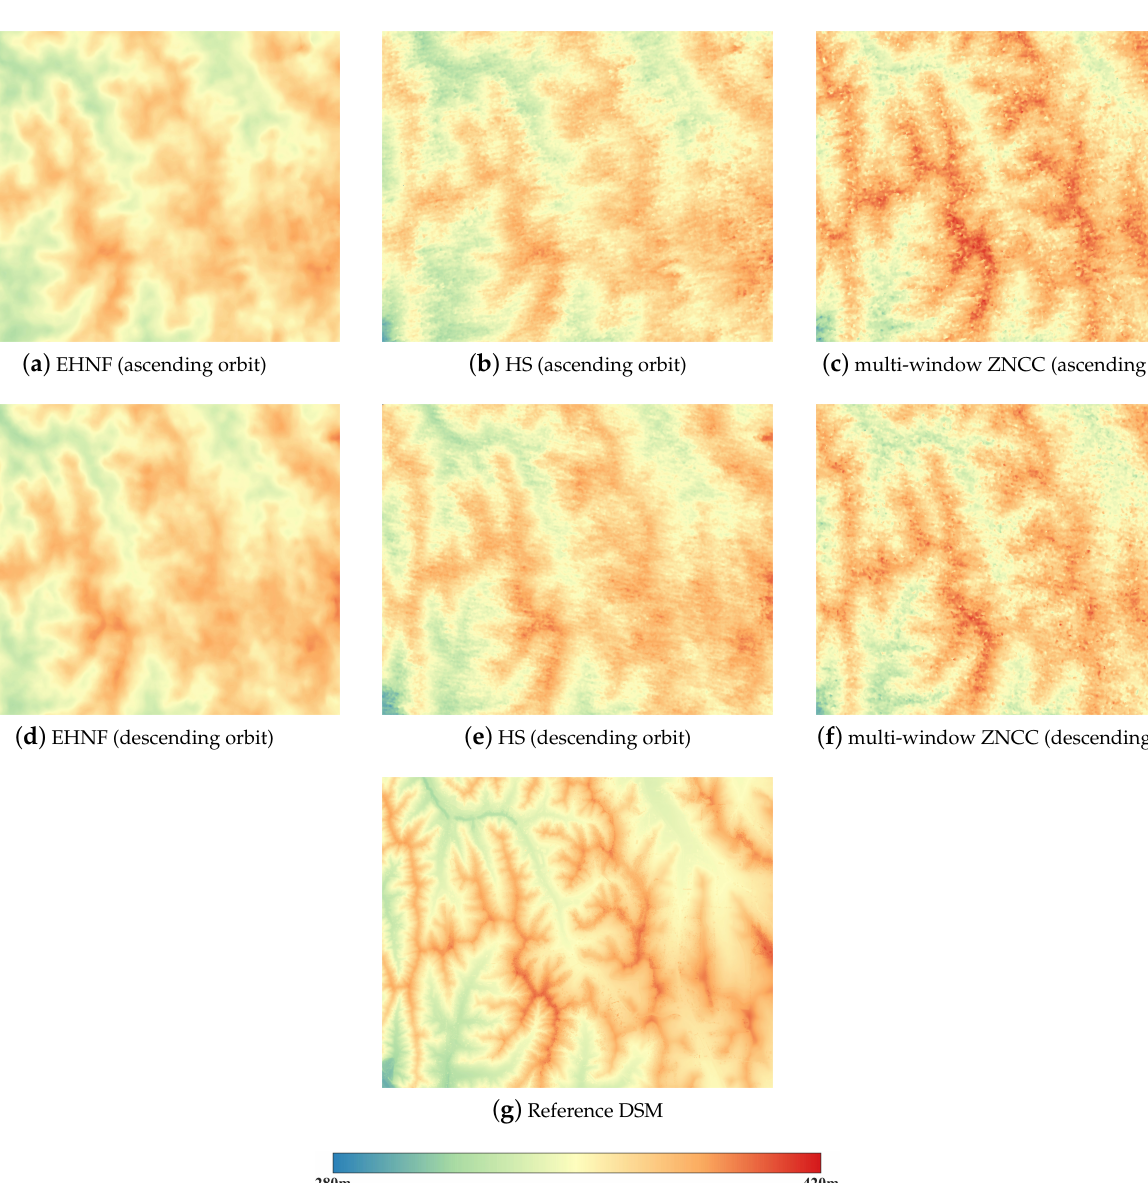
Figure 7. The mountainous DSM generated by the ( a ) EHNF algorithm; ( b ) HS flow algorithm; ( c ) multi-window ZNCC algorithm of ascending orbit stereo images, and ( d ) EHNF algorithm; ( e ) HS flow algorithm; ( f ) multi-window ZNCC algorithm of descending orbit stereo images; and ( g ) the reference DSM generated by LiDAR